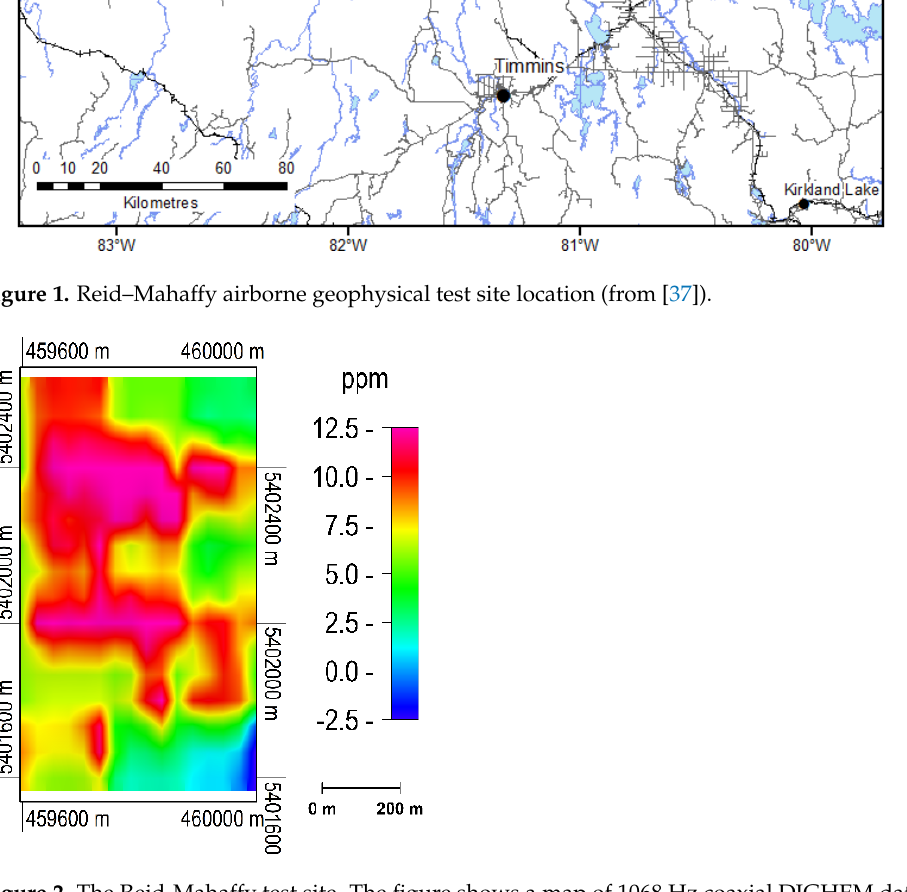
Figure 3. The Reid-Mahaffy test site. The figure shows a map of filtered TMI data.